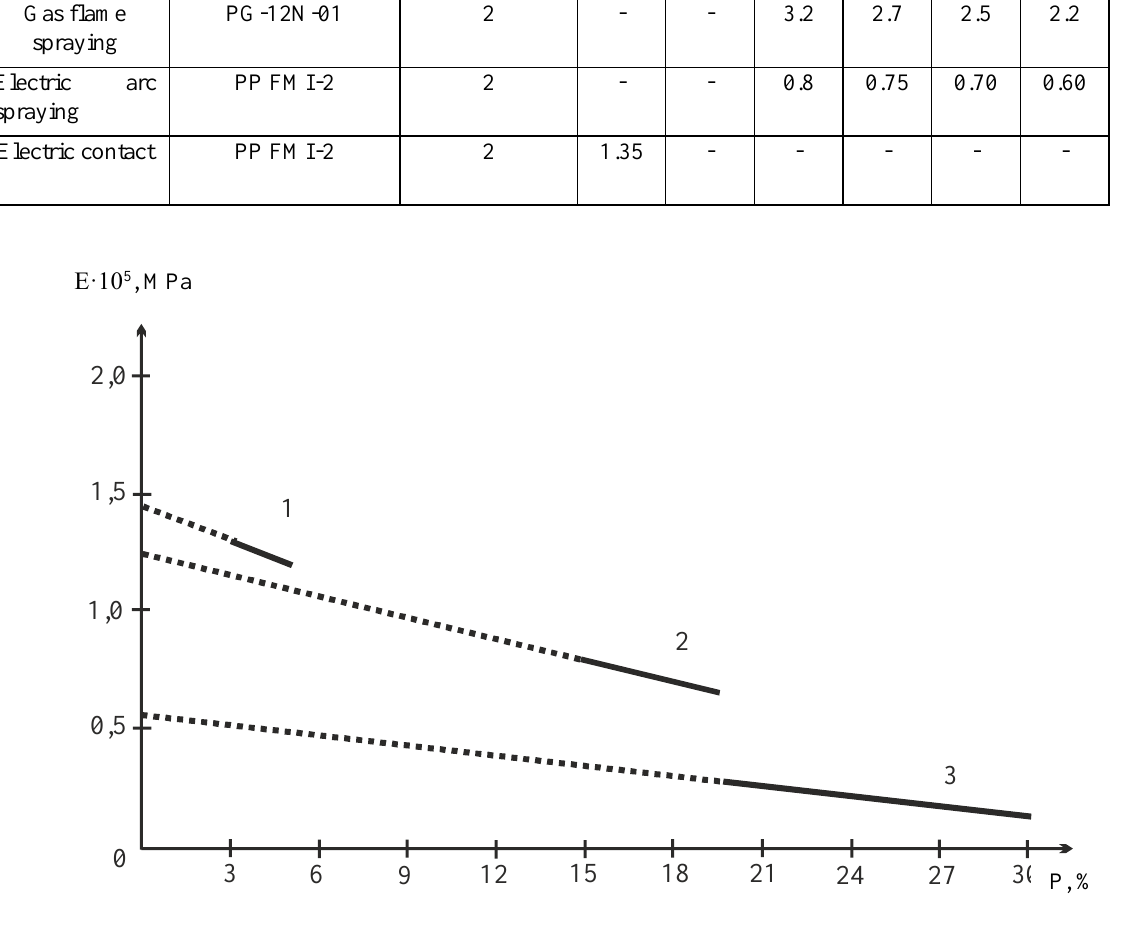
Fig. 1. Relationship between porosity and elastic modulus of coatings: 1 – coating obtained by the electric contact method; 2 – coating obtained by electric arc spraying; 3 – coating obtained by the gas flame method Conditions of the electric contact method for forming coatings: voltage 3 ... 6 V; current 8 ... 12 kA; load on the electrode 10 ... 30 MPa; current pulse time 0.02 ... 0.04 s; pause time 0.02 ... 0.04 s. Conditions of the electric arc spraying: voltage 18 ... 35 V; current 50 ... 600 A; the nozzle-surface distance 50 ... 200 mm; compressed air pressure 0.4 ... 0.5 MPa; compressed gas (air) consumption 60 ... 150 m 3